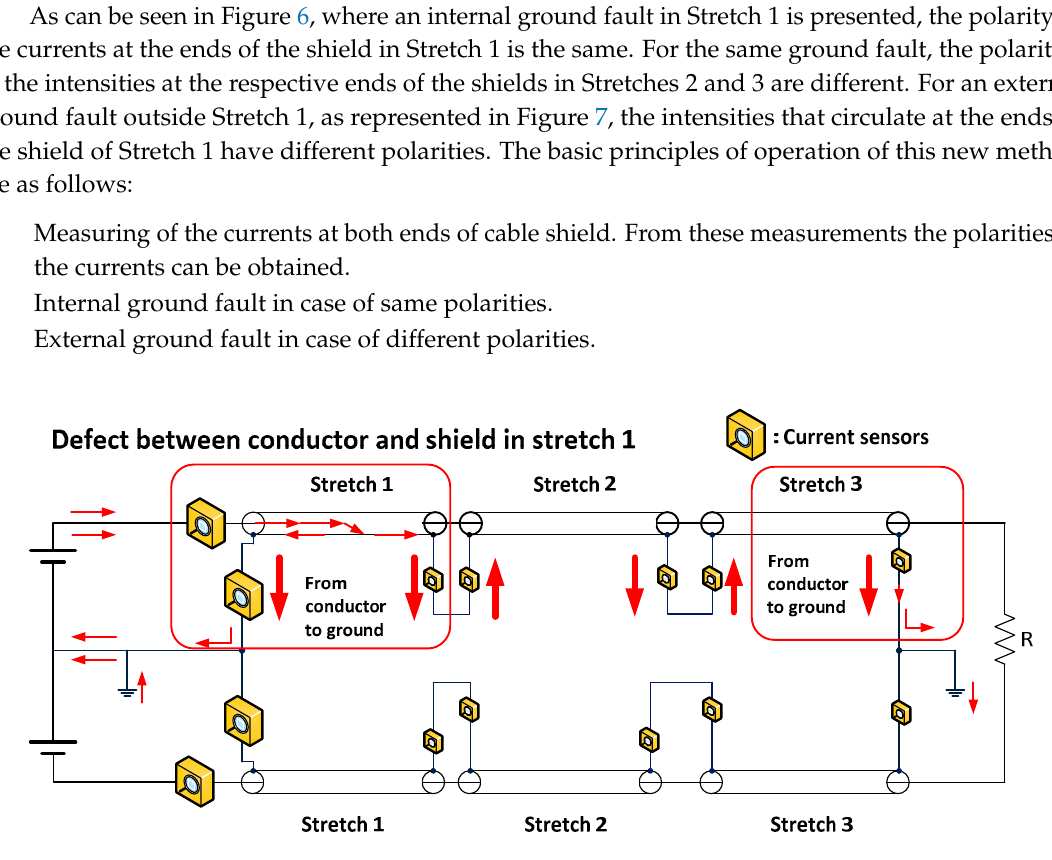
Figure 6. Current circulation for an internal ground fault in Stretch 1.